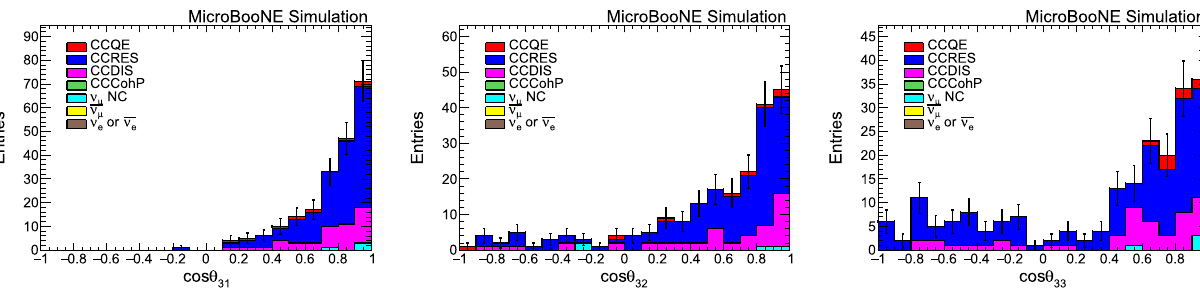
Fig. 35 Multiplicity = 3 cosine of polar angle distribution for candidate muon (left); for second longest track (middle); for shortest track (right) from GENIE default MC. Black error bars represent MC statistical uncertainties